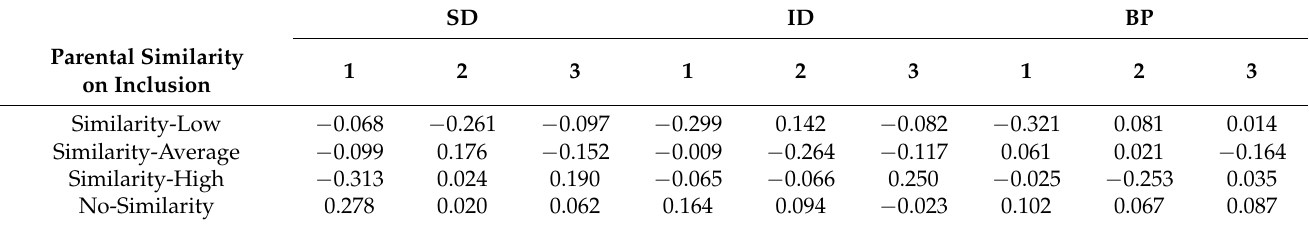
Table 5. Functions at group centroids for the three disabilities